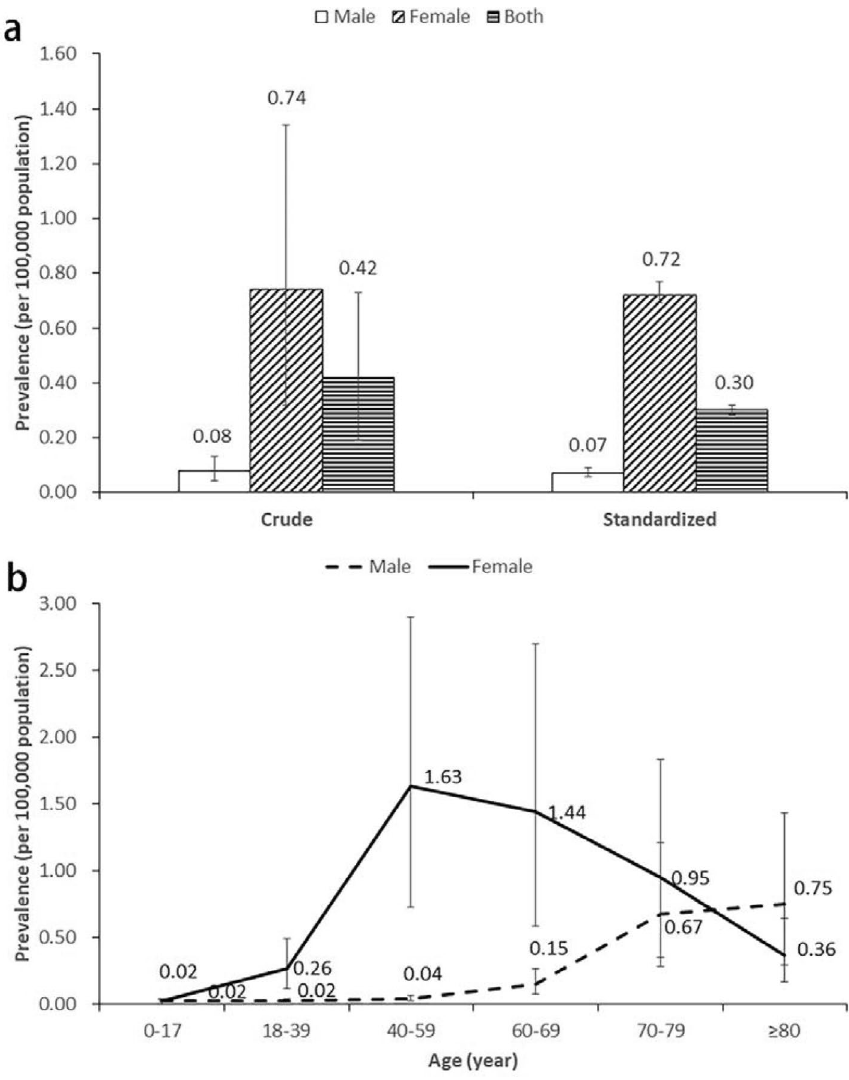
Figure 1. Prevalence of mammary Paget’s disease in urban China in 2016. Note: the standardized prevalence is based on 2010 Chinese census